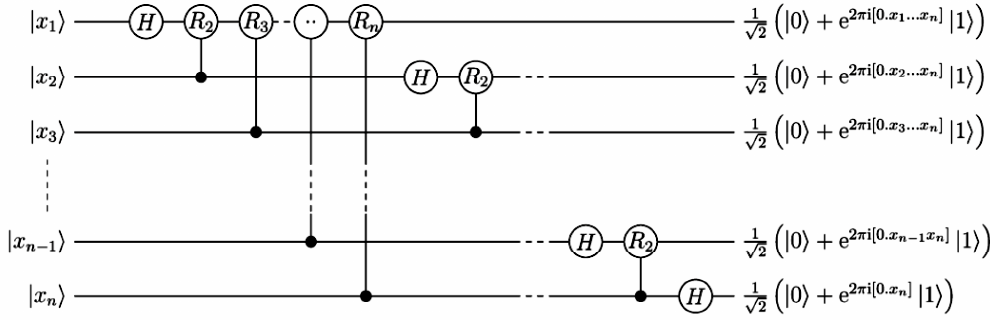
Figure 1. The circuit implementation of n -qubit QFT using the Hadamard gate H and the phase gate R m .